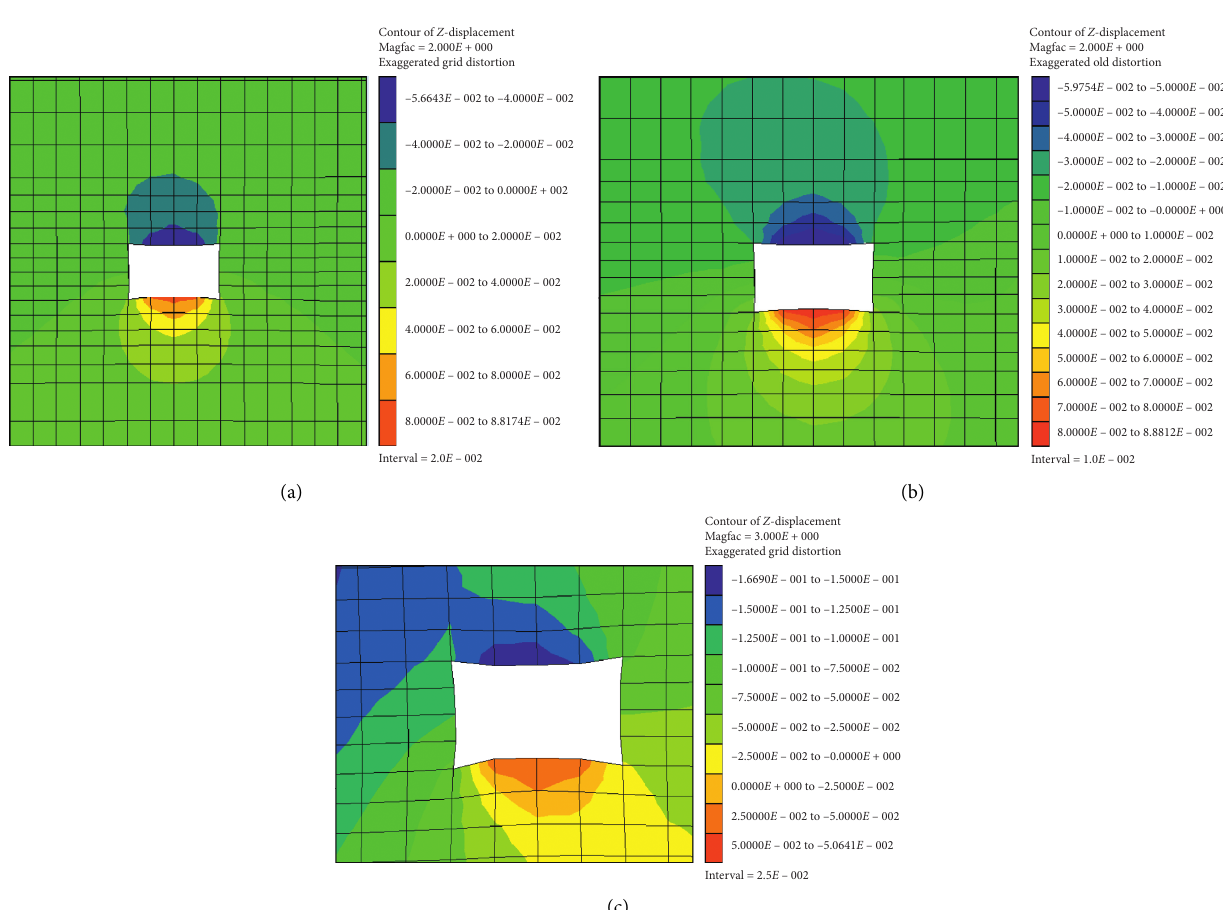
Figure 5: Deformation nephogram of air-return roadway 5103 under multiple excavations and mining conditions. (a) During the ex- cavation of air-return roadway 5103. (b) During the excavation of the top air-return roadway of panel 8103. (c) During the mining of adjacent panel 8101.